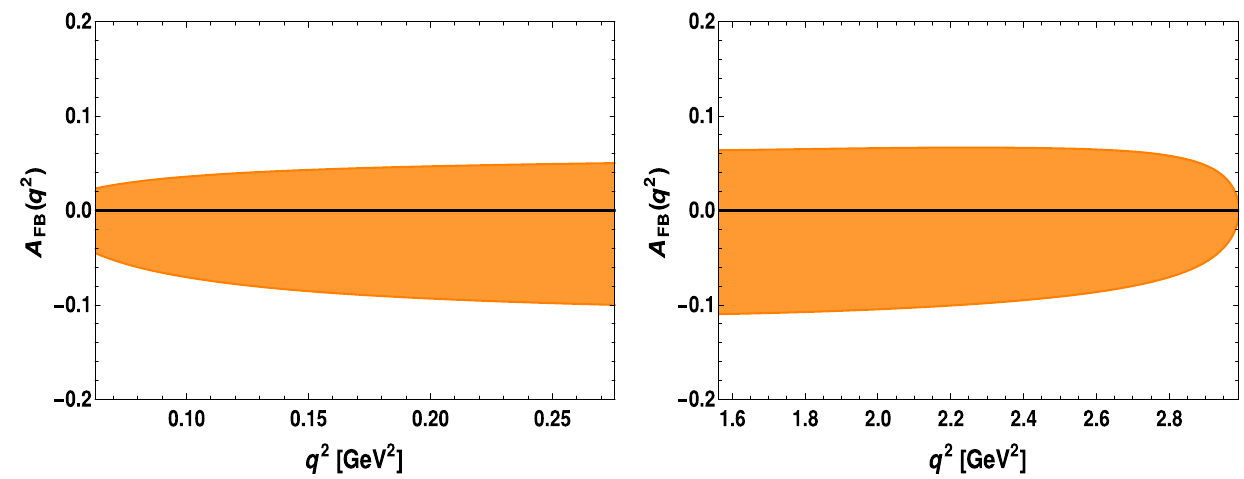
Fig. 4 The variation of the forward–backward asymmetry of D + → π + μ + μ − with respect to low q 2 ( left panel ) and high q 2 ( right panel ) in the scalar leptoquark model